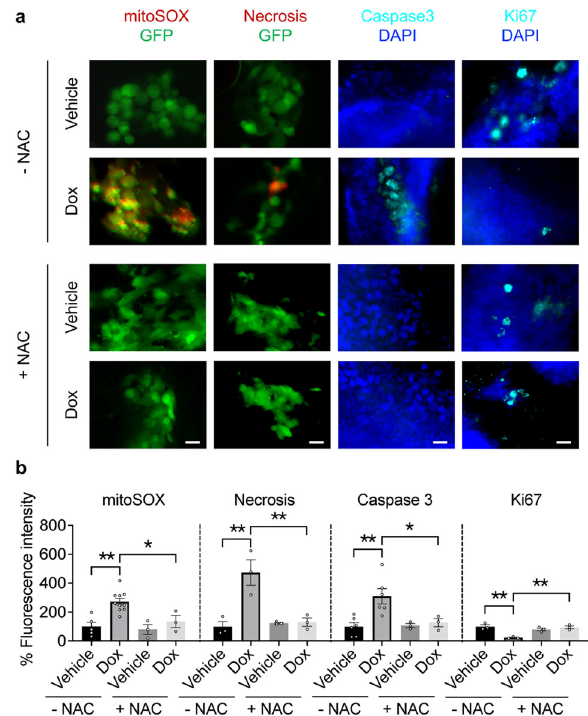
Fig. 7 DLST depletion induces ROS, apoptosis, and necrosis while slowing the proliferation of human DLST-dependent TNBC cells, which can be rescued by NAC treatment. a , b Representative images ( a ) and quantitation ( b ) of mitoSOX (red, a marker for mitochondrial ROS), ethidium homodimer III (red, a marker for necrosis), active-caspase 3 (blue, a marker for apoptosis), and Ki-67 (blue, a marker for cell proliferation) stainings, which were overlaid either with GFP or DAPI signals of tumor cells in the presence or absence of NAC treatment ( n = 3 – 10 fi sh per group). Scale bars = 20 μ m. Data in ( b ) presented as mean±s.e.m. * P ≤ 0.05, ** P ≤ 0.01, *** P ≤ 0.001. Statistical differences were calculated using one-way